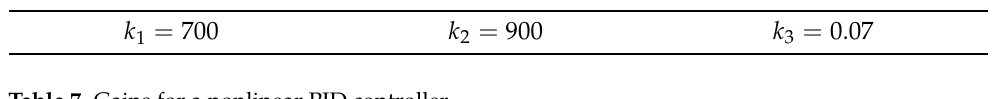
Table 7. Gains for a nonlinear PID controller.